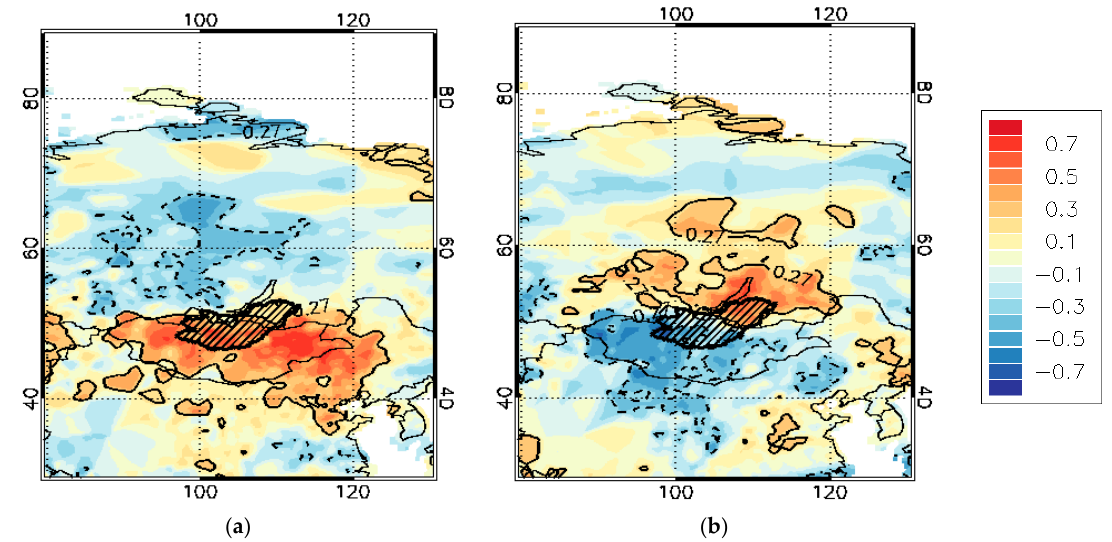
Figure 2. Correlation coefficients between time coefficients of the EOF 1 ( a ), 2 ( b ) of precipitation over the Selenga Basin and normalized precipitation over Eastern Siberia and Mongolia for 1979–2016. The solid black line and dashed line areas indicate the 90% confidence level the positive and negative coefficients of correlation, respectively. The hatched area shows the Selenga Basin.